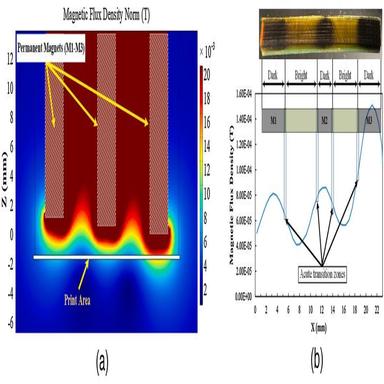
(a) Contour of the COMSOL model showing the magnetic flux density around the bar magnets; (b) Distribution of the magnetic flux density on the print area. The dark-bright bar on top of the figure represents the bar sample with different concentrations of the particles.